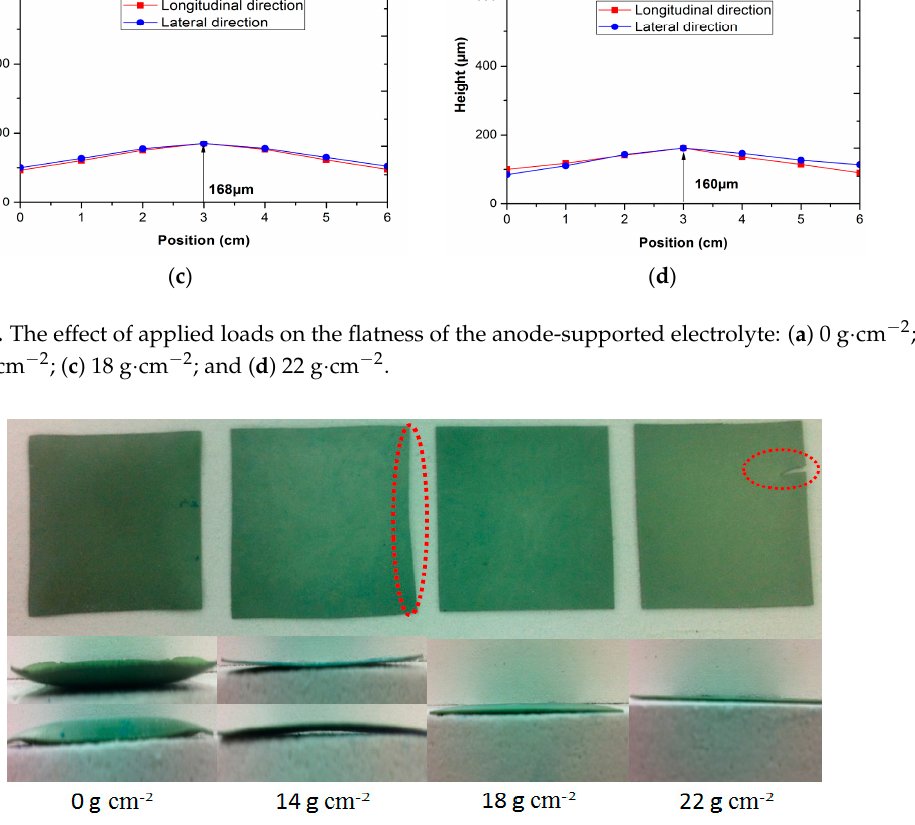
Figure 7. The effect of the applied loads on the deformation of the anode ‐ supported electrolyte substrate.